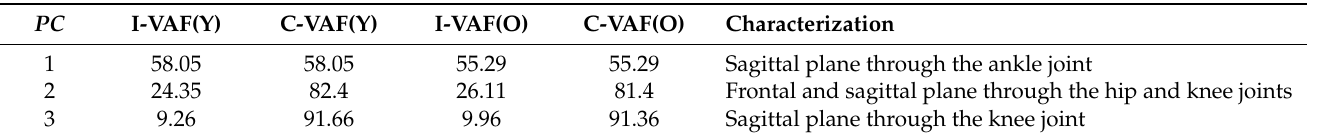
Table 2. Percentage of each individual (I) and cumulative (C) variance explained of each eigenvalue and qualitative interpretation of the first 3 PCs. Y/O: Younger and older